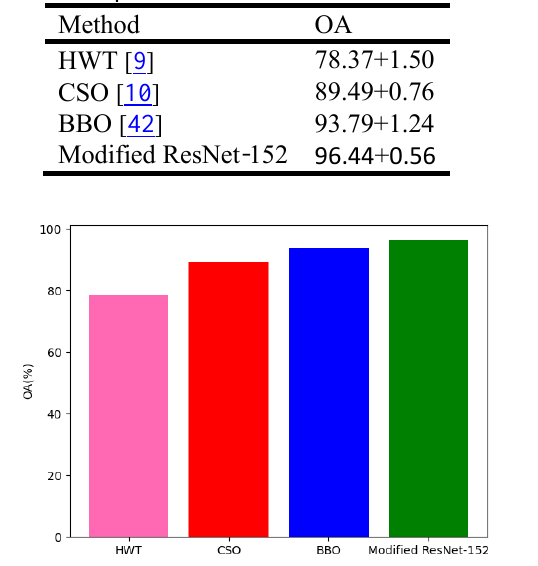
Figure 10. OA of State-of-the-art methods